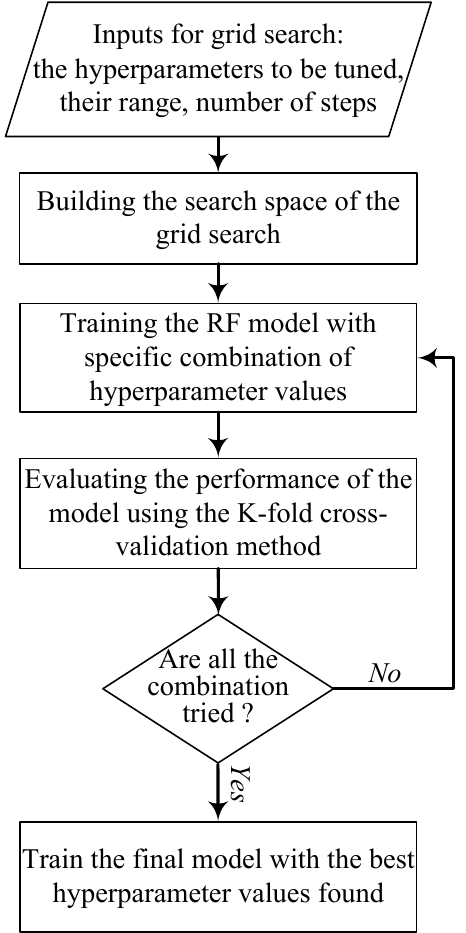
Figure 6. The flowchart of the grid search method.